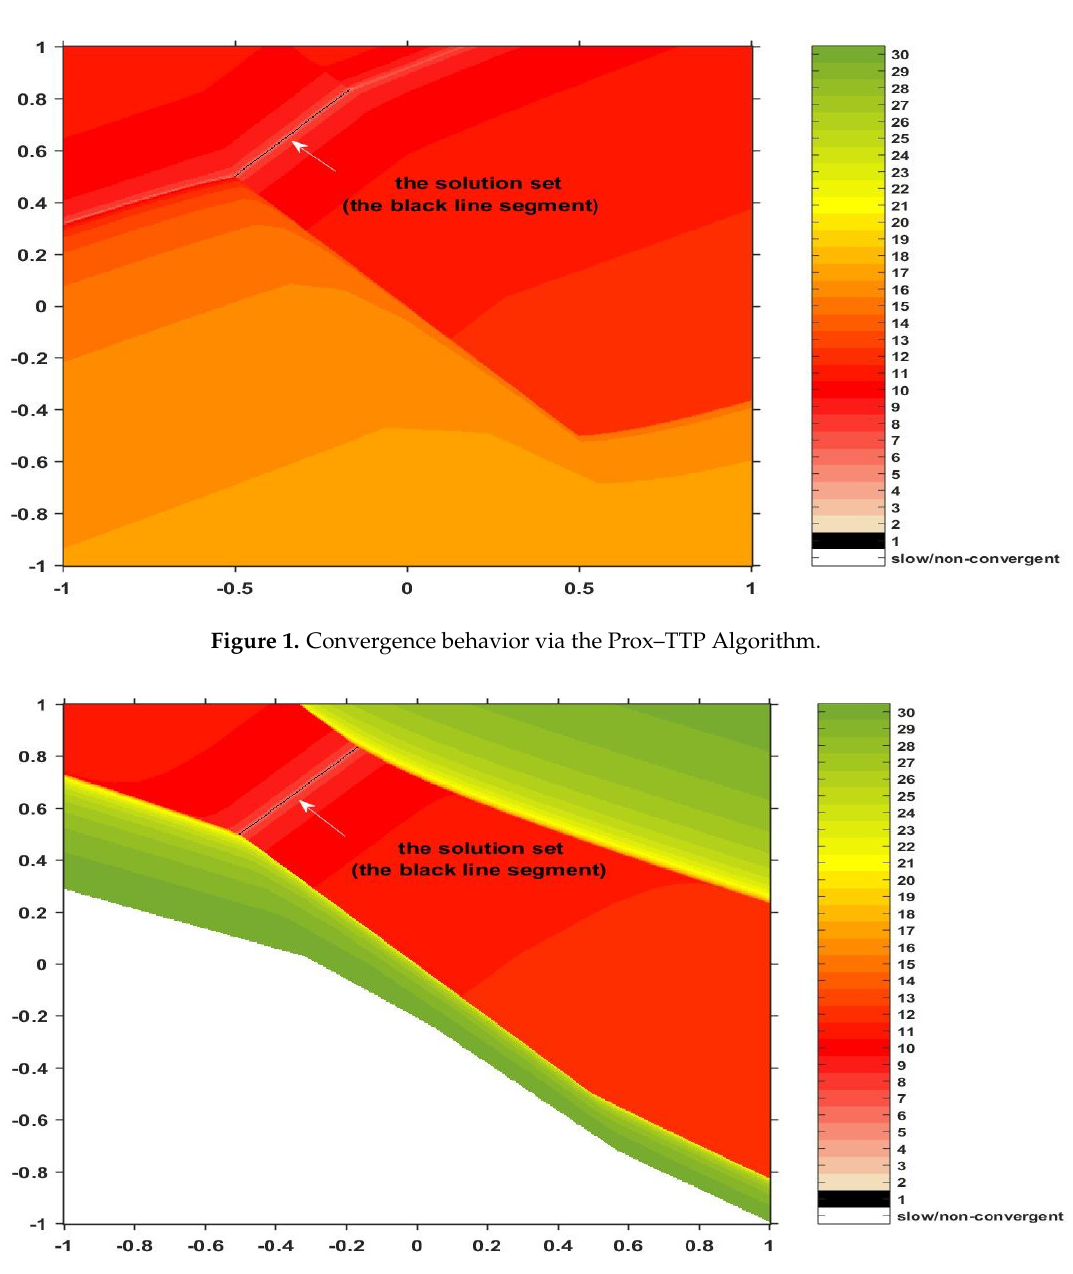
Figure 2. Convergence behavior via the Prox–Standard